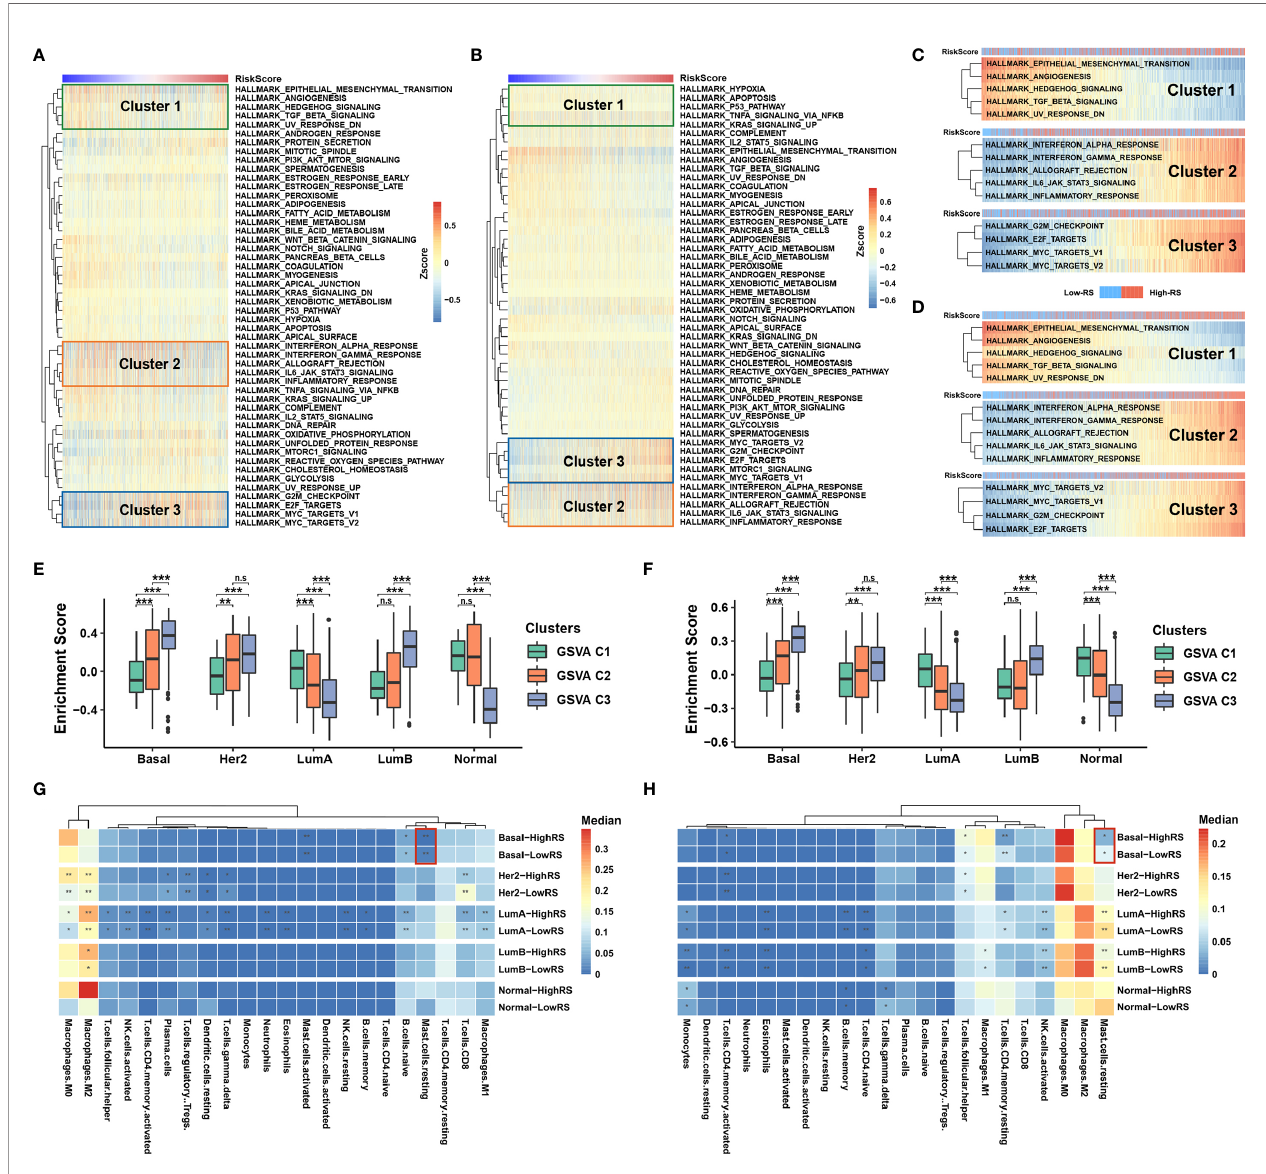
FIGURE 4 | Five-cytokine signature contributes to molecular features of the Basal-like subtype. (A, B) GSVA analysis with hallmark gene sets indicated three pathway clusters in both TCGA (A) and METABRIC (B) cohorts (see Methods ), which were epithelial – mesenchymal transition pathways (Cluster1), in fl ammation or stress response pathways (Cluster2), and cell proliferation pathways (Cluster3). (C, D) The RS level positively correlated Cluster1 and negatively associated Cluster2 and Cluster3 in both TCGA (C) and METABRIC (D) datasets. (E, F) Average enrichment score of the three distinct clusters among PAM50 subtypes in TCGA (E) and METABRIC (F) datasets. (G, H) Differential immune cell proportions of high- and low-RS groups within each PAM50 subtype in TCGA (G) and METABRIC (H) cohorts, respectively. P value indicated by Wilcoxon rank sum test and adjusted by Benjamini-Hochberg method. ***FDR < 0.001; **FDR < 0.01; *FDR < 0.1. n.s., non-signi fi